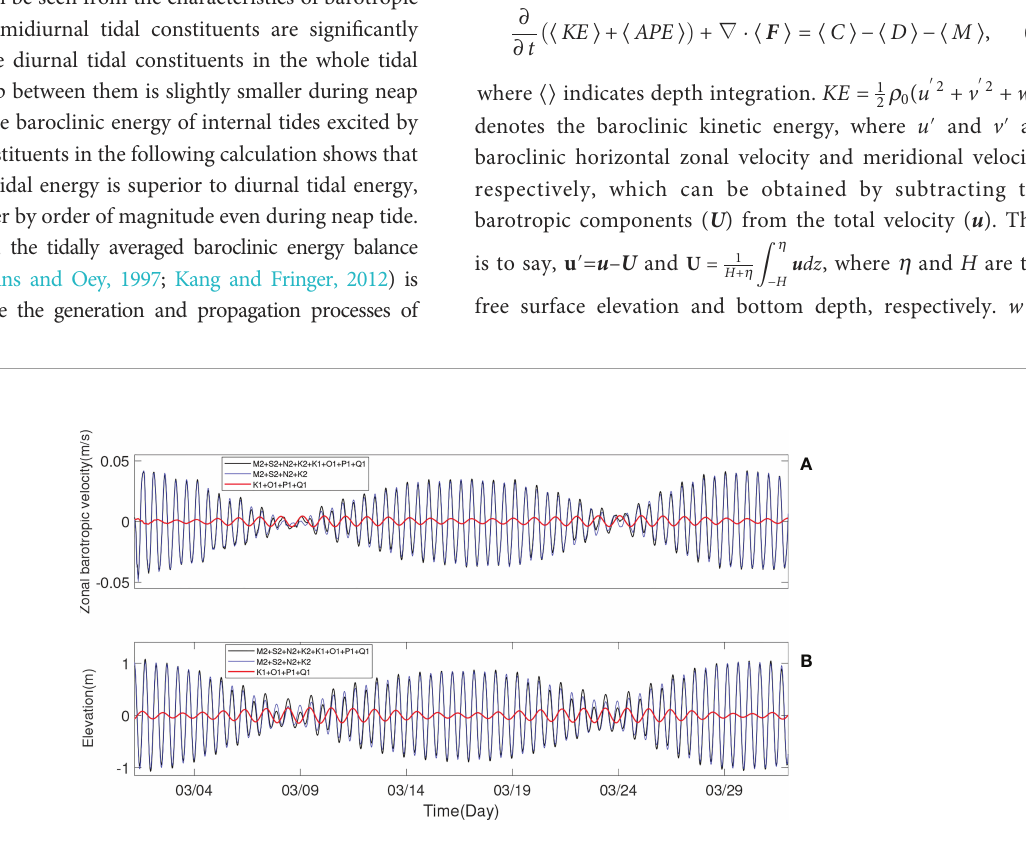
FIGURE 6 The time series of (A) model-simulated zonal barotropic velocity for Experiment 1 – 3 and (B) barotropic sea surface elevation derived from TPXO8 from 1 March to 31 March at Station 1 (see the red triangle in Figure 1), among which the black curve represents the eight main tides, the blue curve represents the four main semidiurnal tides, and the red curve represents the four main diurnal